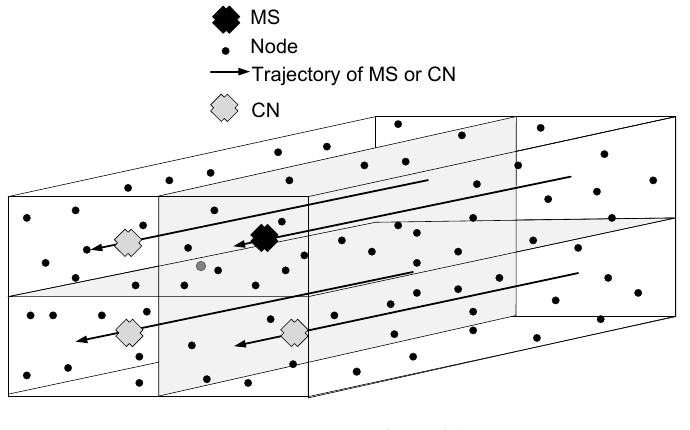
Figure 3. Network model.